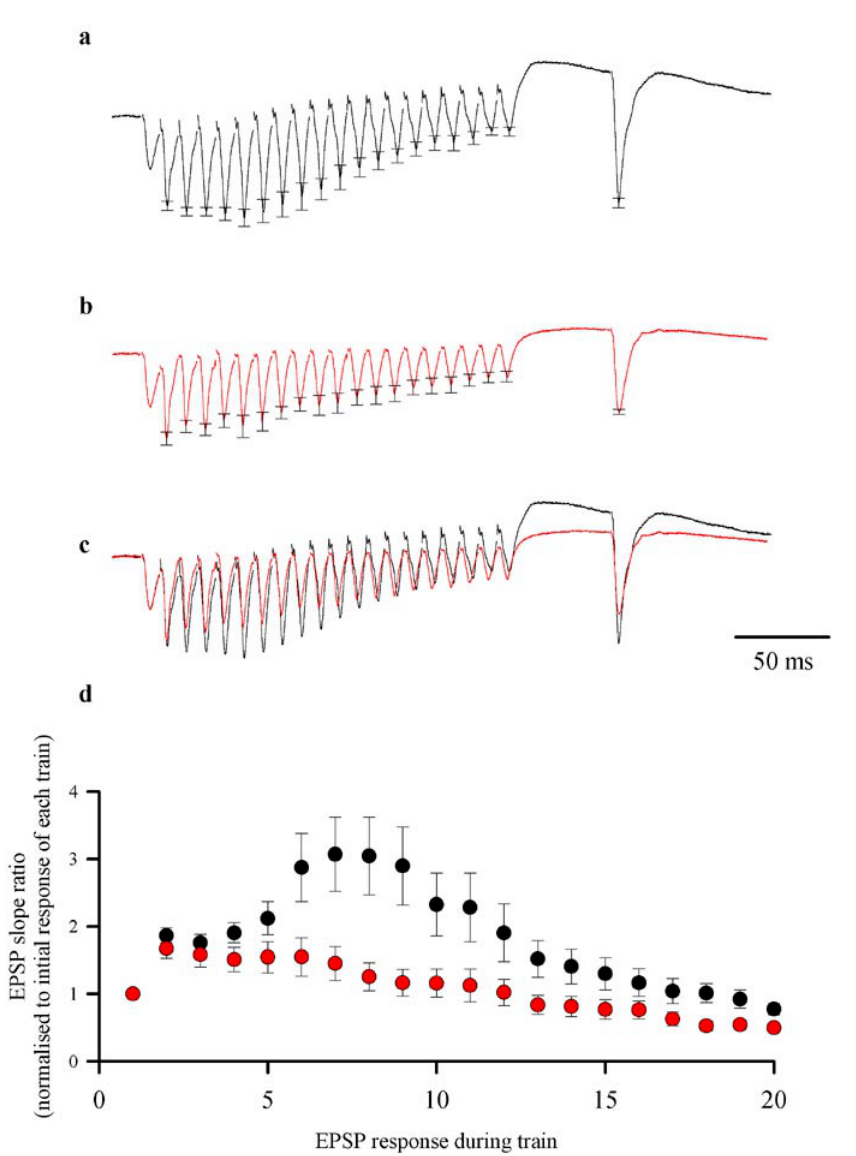
FIGURE 2. High frequency synaptic transmission is reduced in mGlu7 knockout mice. Pooled traces illustrating reduced AMPA receptor(cid:150)mediated EPSPs during the train and in response to the test pulse for 8 slices from wildtype (a) and 8 slices from mGlu7 knockout (b) mice. The ratio of each EPSP in relation to the initial response of each train is shown superimposed